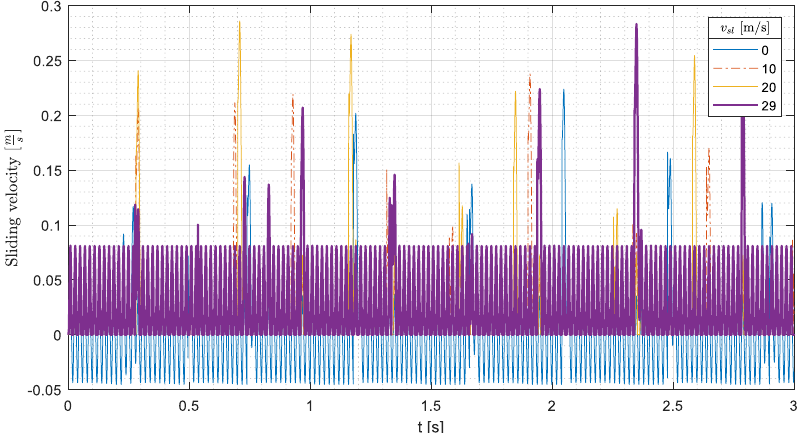
Figure 10. Numerical results, sliding velocity of the cylindrical part along the track, 𝜃 = 3° , 𝑓 𝑣 = 0.005 , 𝜇 𝑐 = 0.3,𝜇 𝑠 = 0.6 , and parametric values of 𝜓 .